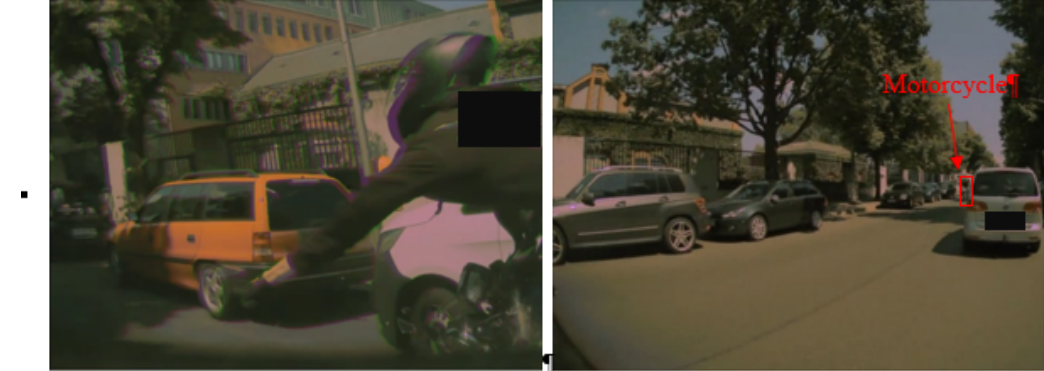
Figure 3: Freeze frame of system video (front camera) at immediate point of collision (left) and visual occlusion by VW Touran approaching from forward looking flank-mounted camera